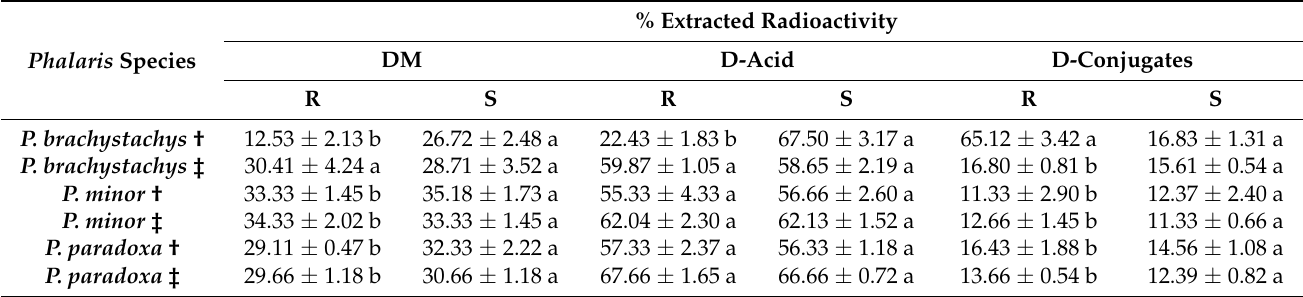
than in its S counterpart (Table 2). Pretreatment with ABT solution severely decreased and polar conjugates reached concentrations similar to those observed in the S population and in the other R and S populations of P. minor and P. paradoxa . In these populations, the percentages of DM, DM acid, and D-conjugates ranged from 29 to 35%, from 55 to 67%, and from 11 to 16%, respectively. Table 2. 14 C-Diclofop-methyl (DM) percentage and metabolites retrieved from shoots after application to leaves in resistant (R) and susceptible (S) biotypes of Phalaris species 48 h after treatment